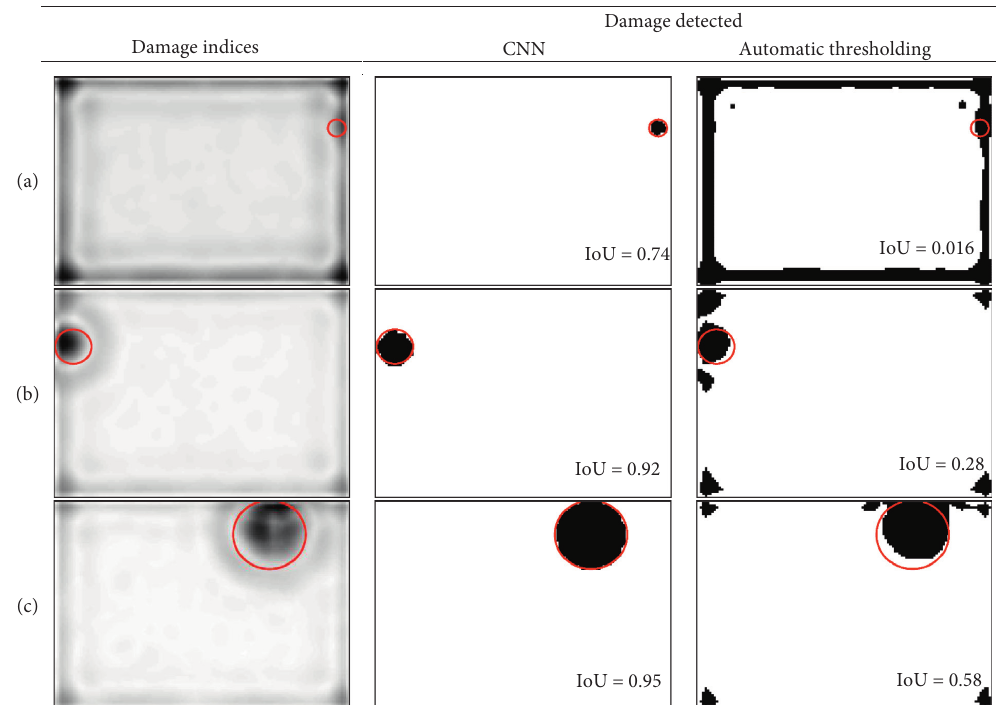
Figure 11: Damage detected using CNN and automatic thresholding method. Normalized damage sizes: (a) 0.05, (b) 0.1, and (c) 0.2. The red circles indicate the true damage.